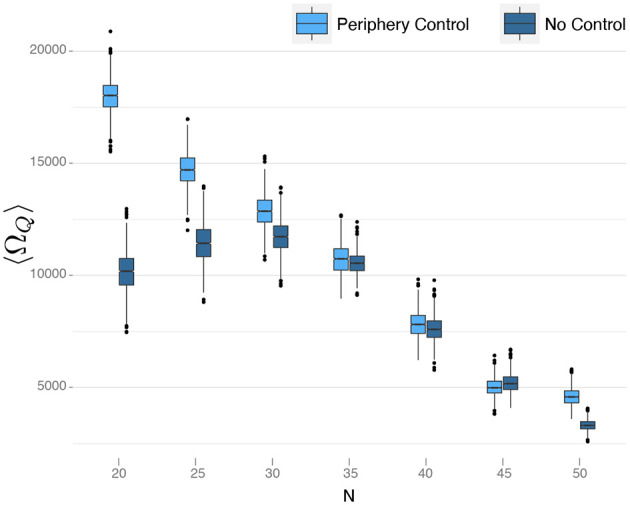
Comparison of different periphery control approaches with fixed control signal. The effectiveness of the control method without adapting the signal to the size of the network decreases with size. In the figure are plotted bootstrap samples for 〈ΩQ〉 obtained from 100 simulations for each network size and each strategy. The control signal used is u = −0.05.